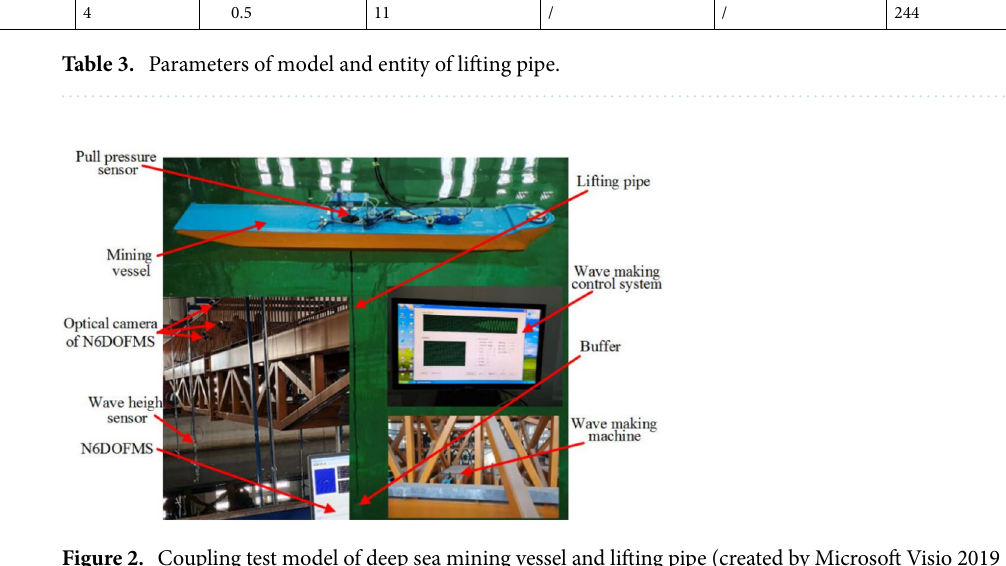
Figure 2. Coupling test model of deep sea mining vessel and lifting pipe (created by Microsoft Visio 2019 software, URL: https:// www. micro softs tore. com. cn/ visio/ visio- stand ard-